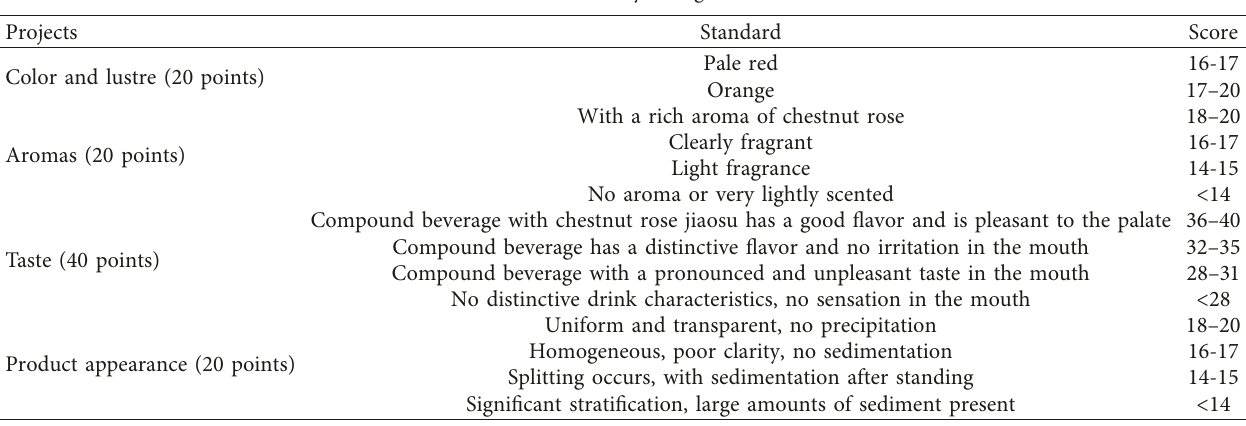
Table 6: Sensory rating scale.